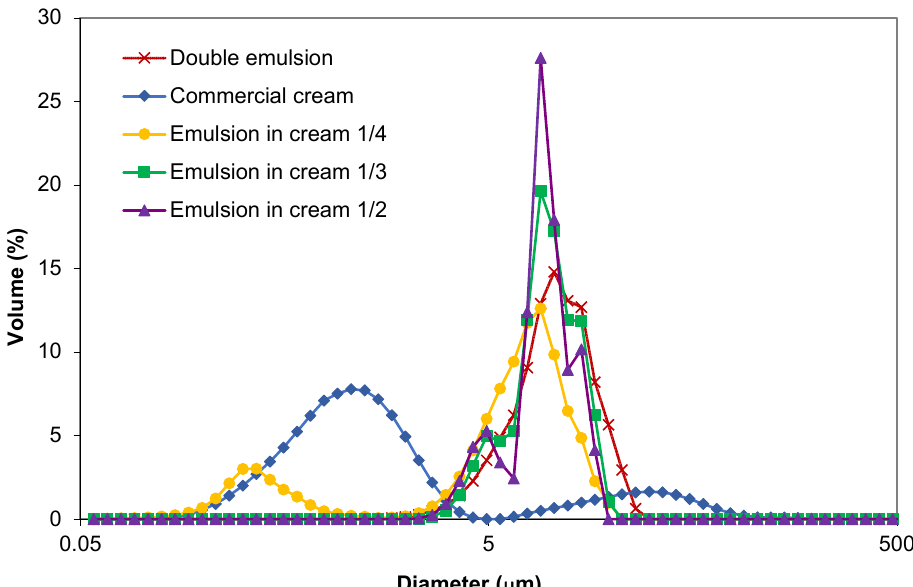
Figure 1. Droplet size distribution of double emulsion, commercial cream and cream ‐ emulsion mix ‐ tures.